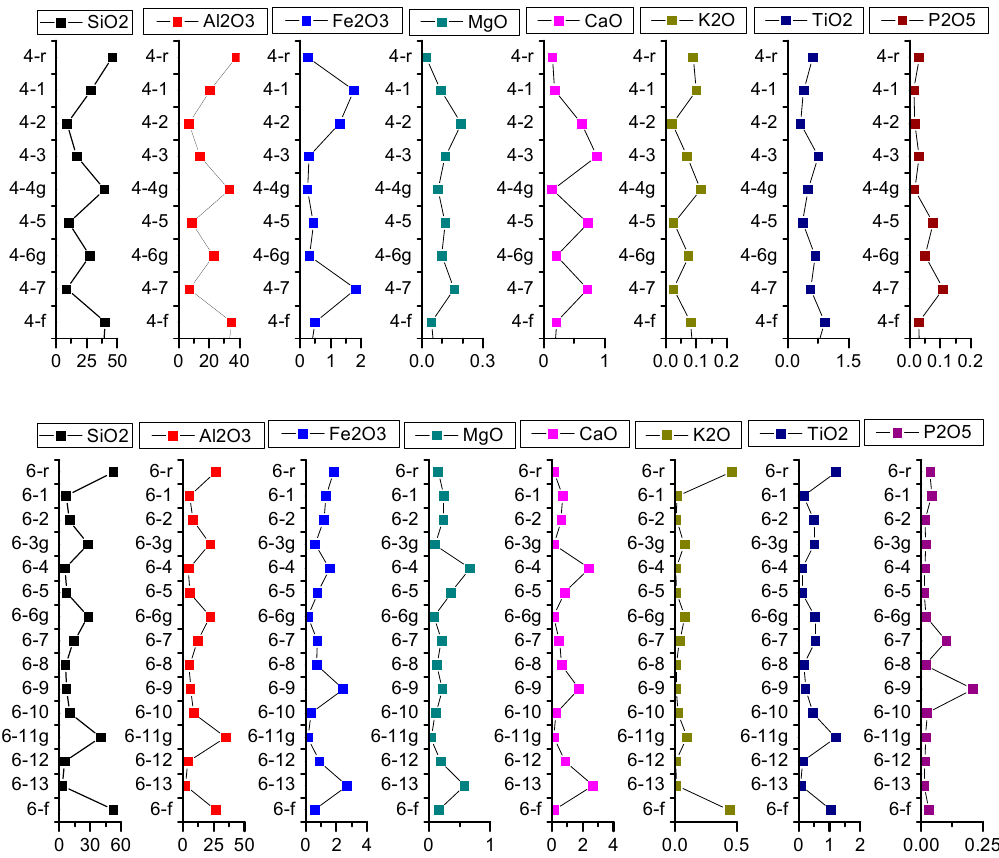
Figure 5. The content variation in major elements in the section column for No. 4 and No. 6 coal.